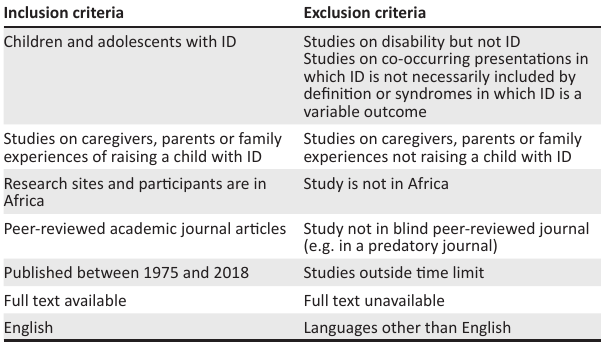
TABLE 1: Eligibility - inclusion and exclusion criteria.